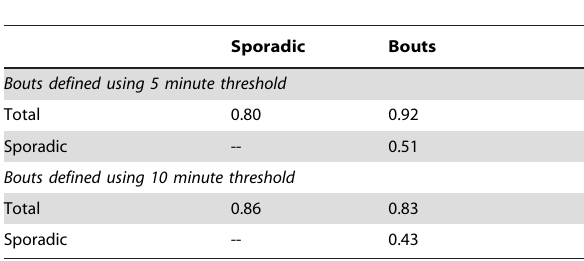
Table 2. Partial correlations (adjusted for sex, ethnicity,